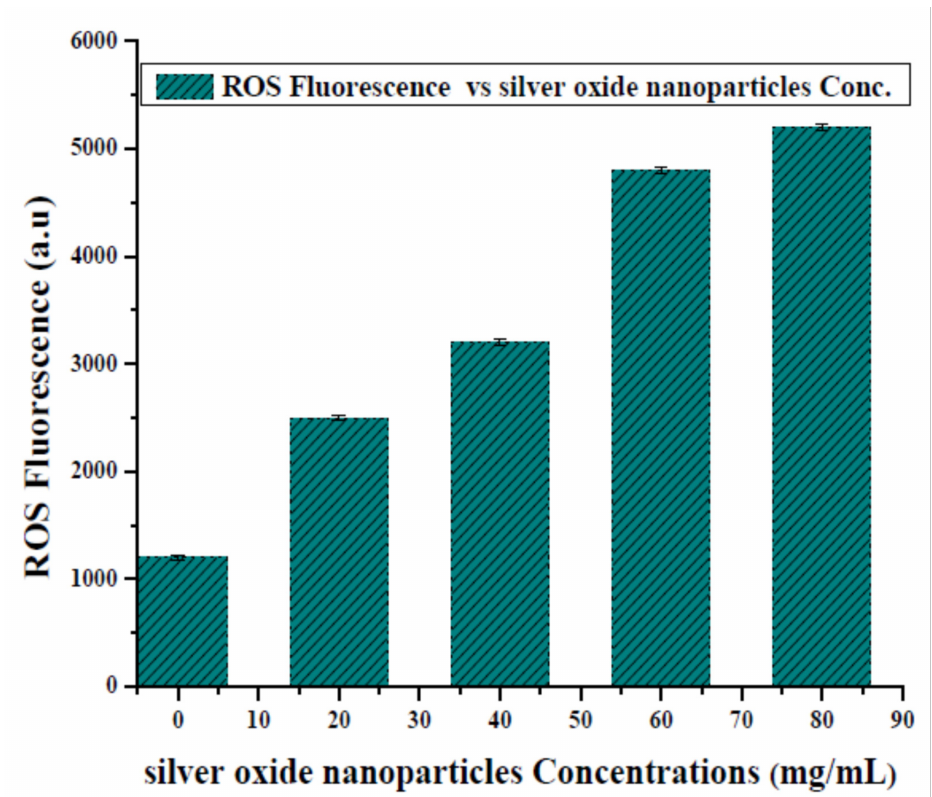
Figure 11. ROS fluorescence (a.u) for silver oxide nanoparticles exposed in in vitro HepG2 model (adapted with permission from reference